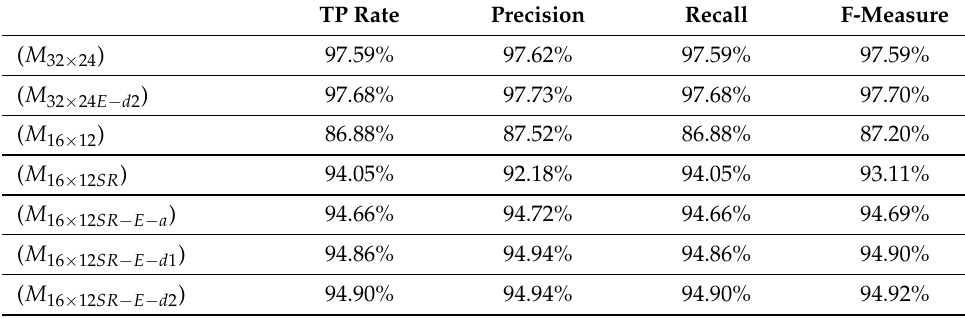
Table 10. The classification TP rate, precision, recall and F1-score on the test set. TP Rate Precision Recall